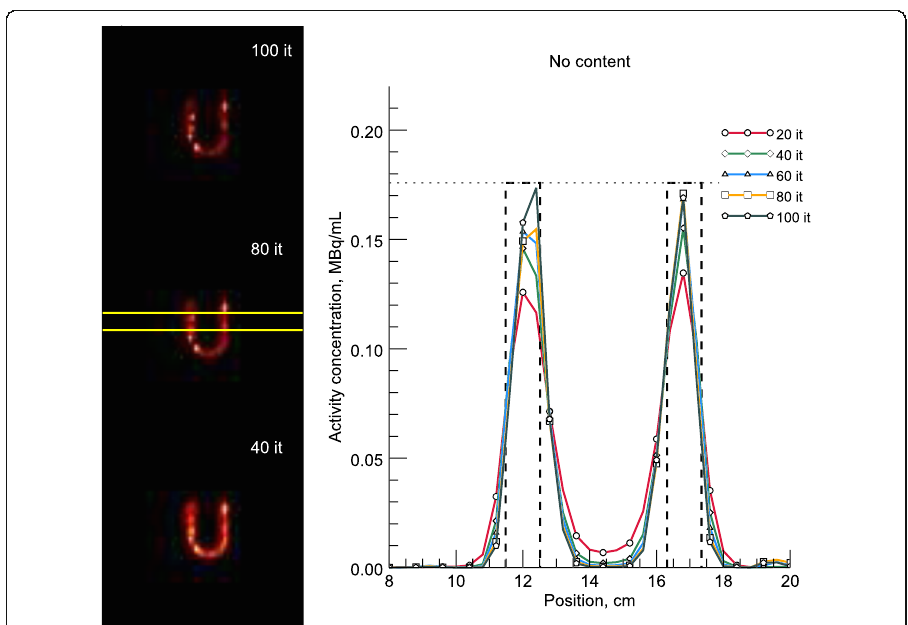
Fig. 8 Line profiles over a reconstructed myocardium with the myocardiac insert in an empty torso. On the left are three long-axis images, corresponding to 40, 80, and 100 iterations. The summed profile was calculated from the seven rows in between the yellow markings and includes the data for every 20th iteration. Only alternate data points are marked for clarity. The reference activity concentration, shown by a horizontal dotted line, in the myocardium at the start of the measurement was 0.18